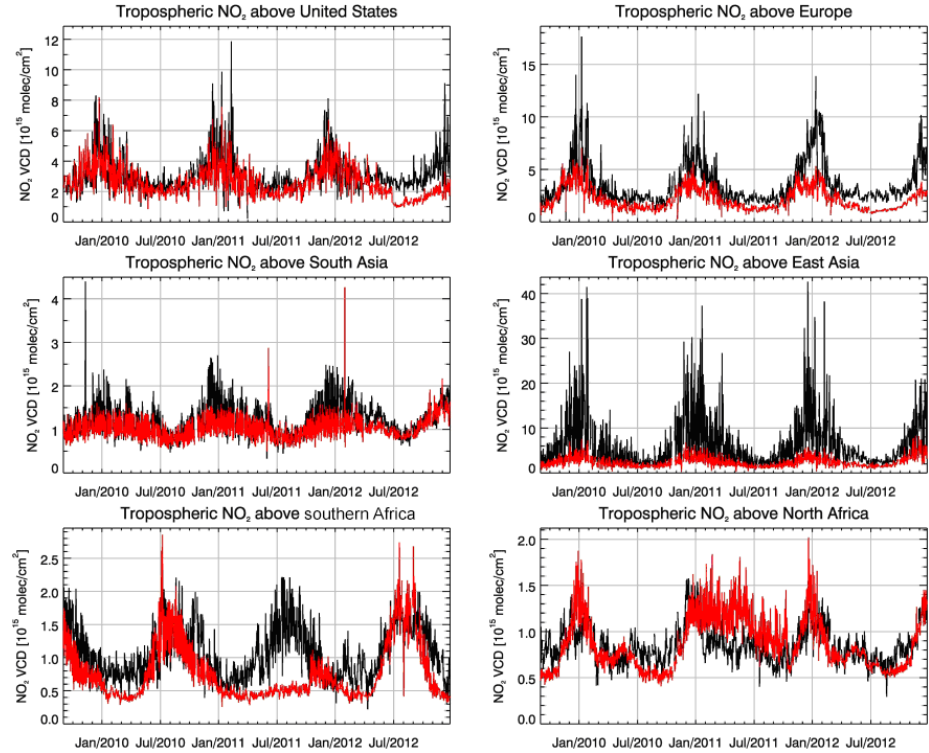
Figure 16. Time series of daily tropospheric NO 2 VCD [10 15 moleccm − 2 ] averaged over different regions. Top: United States (left), Europe (right); second row: South Asia (left), East Asia (right); bottom: southern Africa (left), North Africa (right). Black lines show satellite observations (SCIAMACHY up to March 2012, GOME-2 from April 2012 to December 2012), red lines correspond to the MACC_osuite simulations.